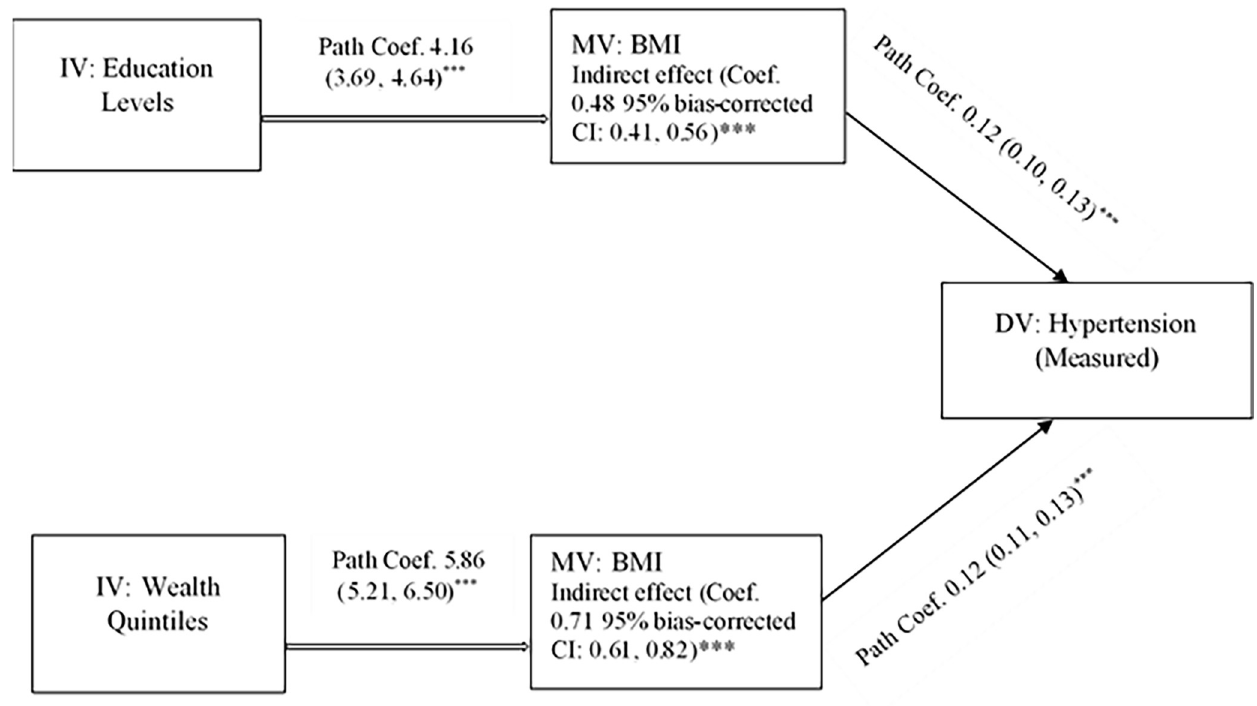
Fig 3. Mediating role of BMI in the association between SES and hypertension (measured) in Nepal. Path coefficients (95% CI) and indirect effect of SES on hypertension through BMI with bias-corrected 95% confidence intervals are reported. � p < 0.05, �� p < 0.01, ��� p < 0.001. CI = Confidence Interval, BMI = Body Mass Index, DV = Dependent Variable, IV = Independent Variable, MV = Mediating Variable, SES = Socioeconomic Status.